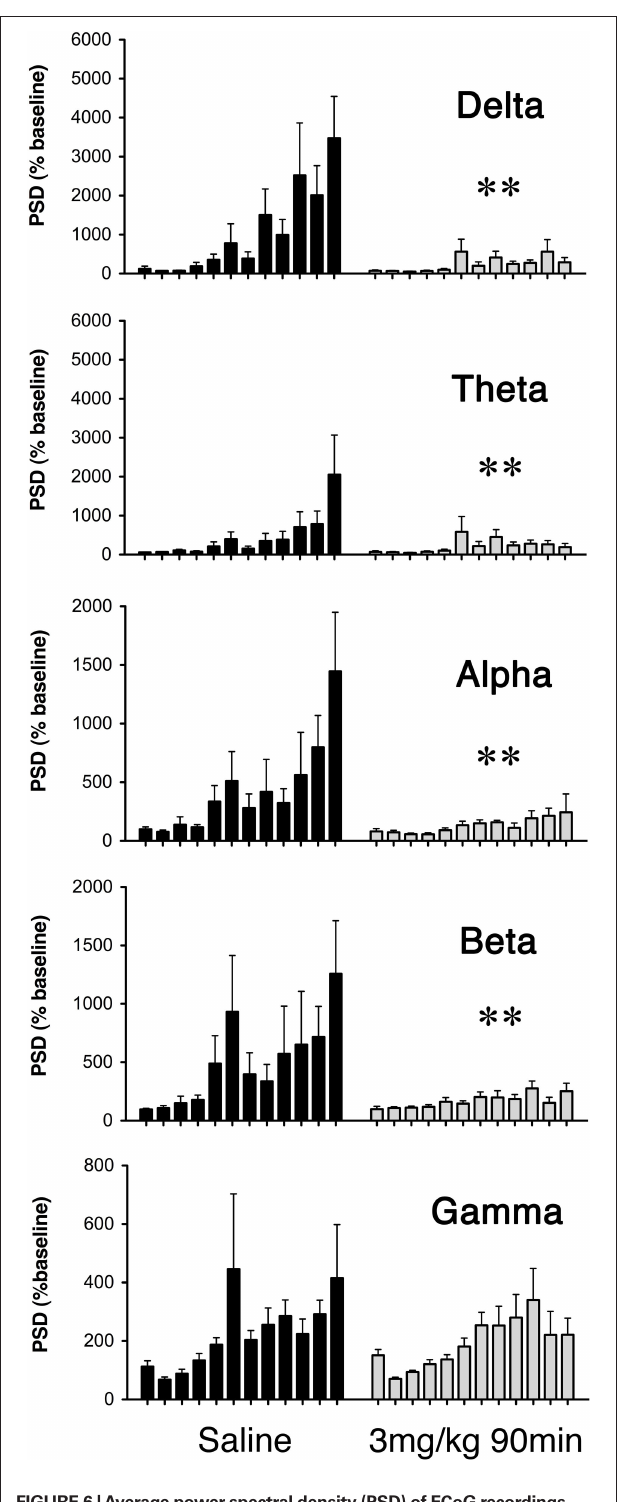
FIGurE 6 | Average power spectral density (PSD) of ECoG recordings during seizure induction for saline (dark bars) and GYKI 52466 (3 mg/kg 90 min; light bars) preconditioned rats. Histograms show average PSD (mean ± SEM) for each 10-min epoch during the 2-h KA challenge. Preconditioning effects were analyzed separately for each frequency band (Delta (1.25–4.5 Hz); Theta (4.75–6.75 Hz); Alpha (7.00–12.5 Hz); Beta (12.75–35 Hz); Gamma (35.5–100 Hz). ** p <